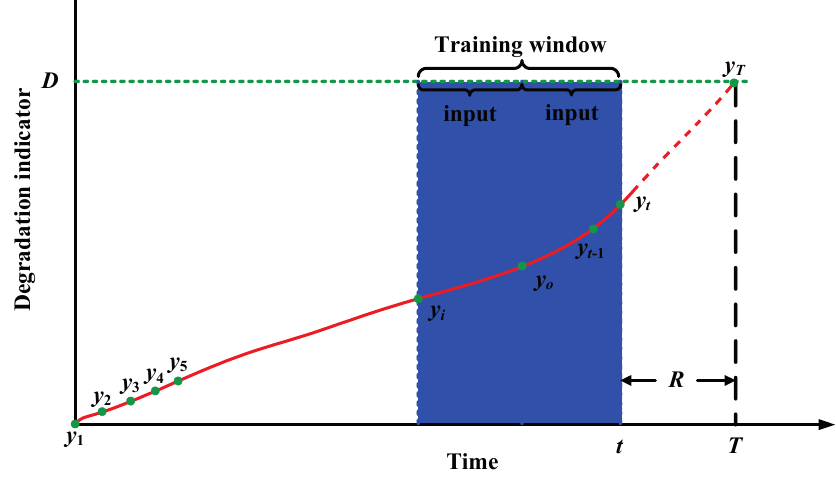
Figure 5. Illustration of the training